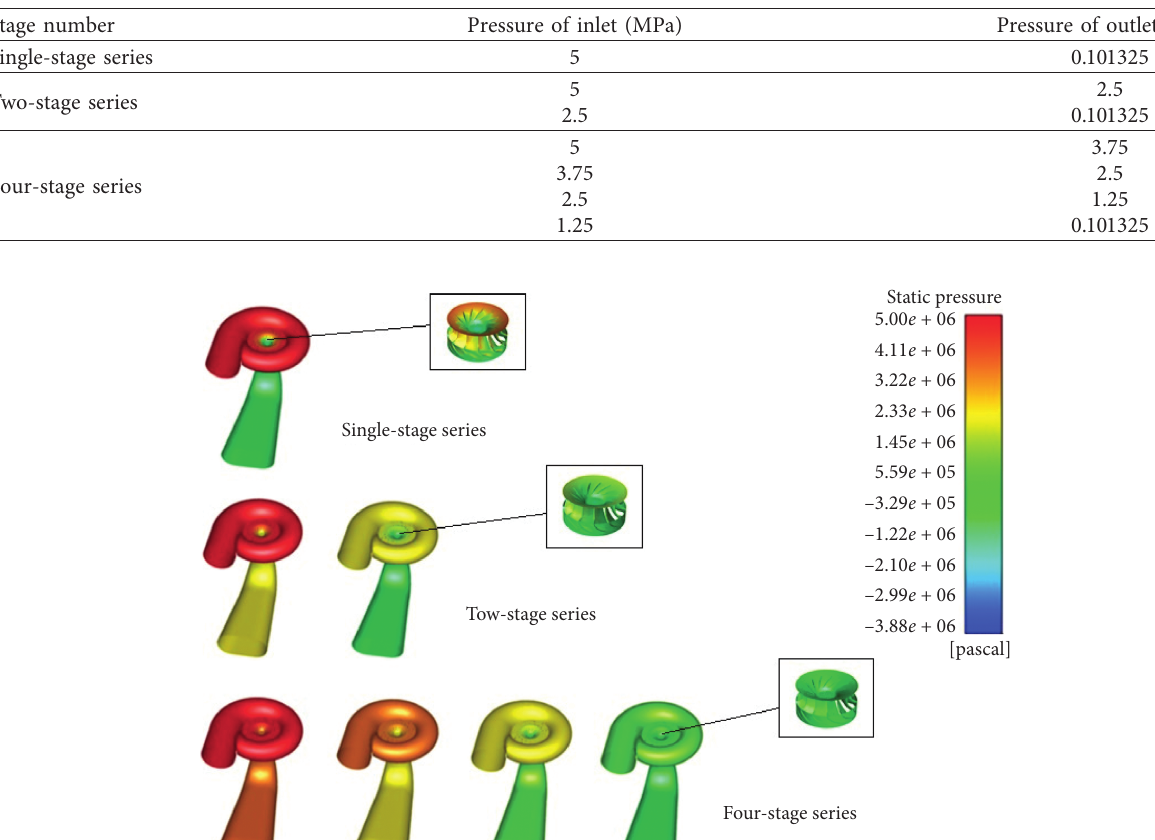
Table 3: Inlet and outlet pressure of each stage for different series modes.